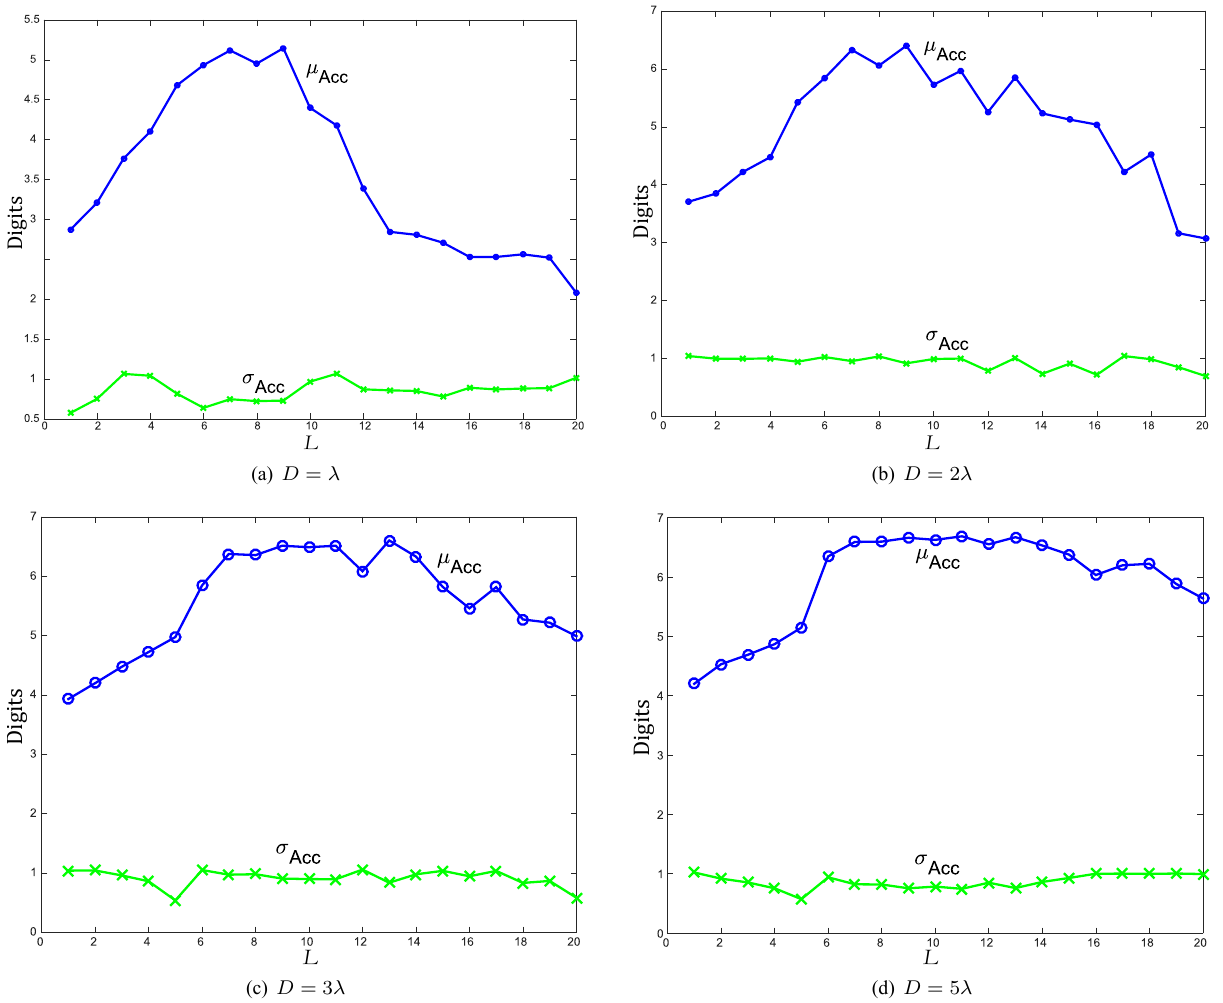
Figure 3: Relative accuracy of EFIE solutions (current weights of RWG basis functions) for different values of L and D for the benchmark scatterer shown in Fig. 2. µ Acc is the arithmetic mean and σ Acc is the standard deviation of the accuracy of magnitudes of the entries of vector [ I GFE ] , in digits, computed from [ ǫ I ( L )]